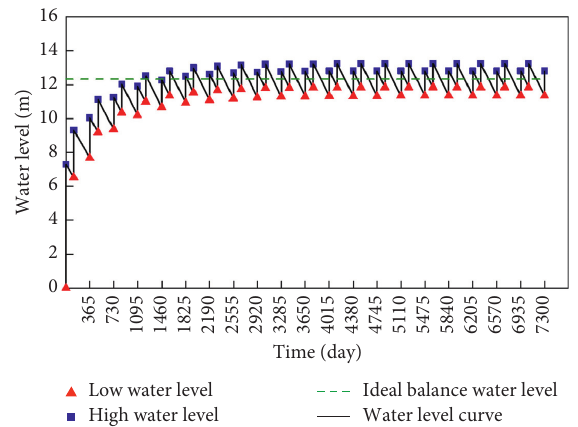
Figure 9: Water level fluctuation when two instantaneous rainfalls enter the reservoir under the intermediate conditions each